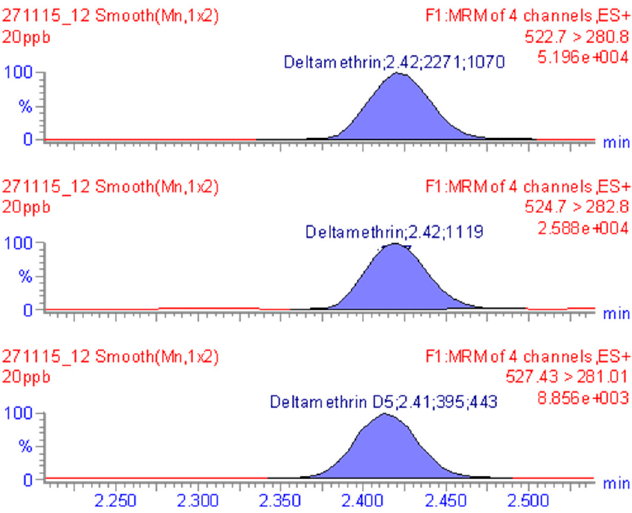
− 1 of deltamethrin